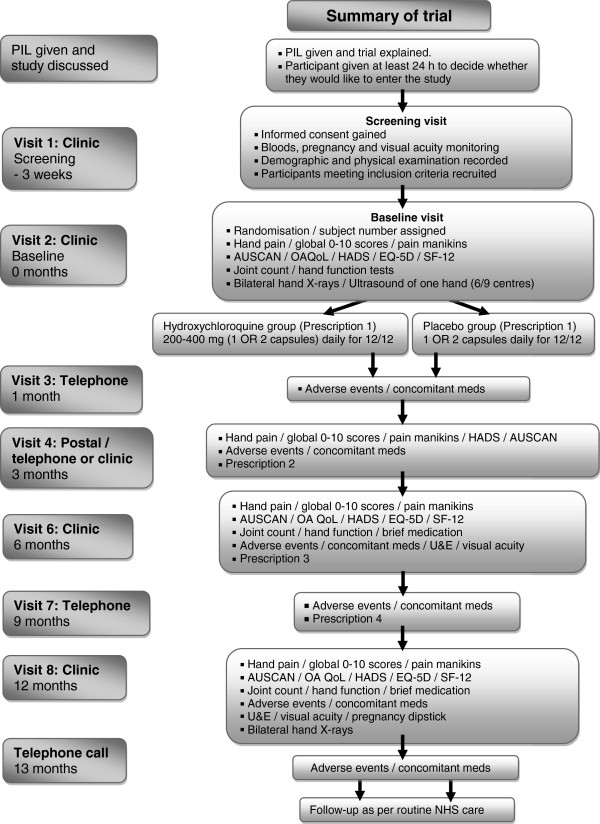
Summary of trial.